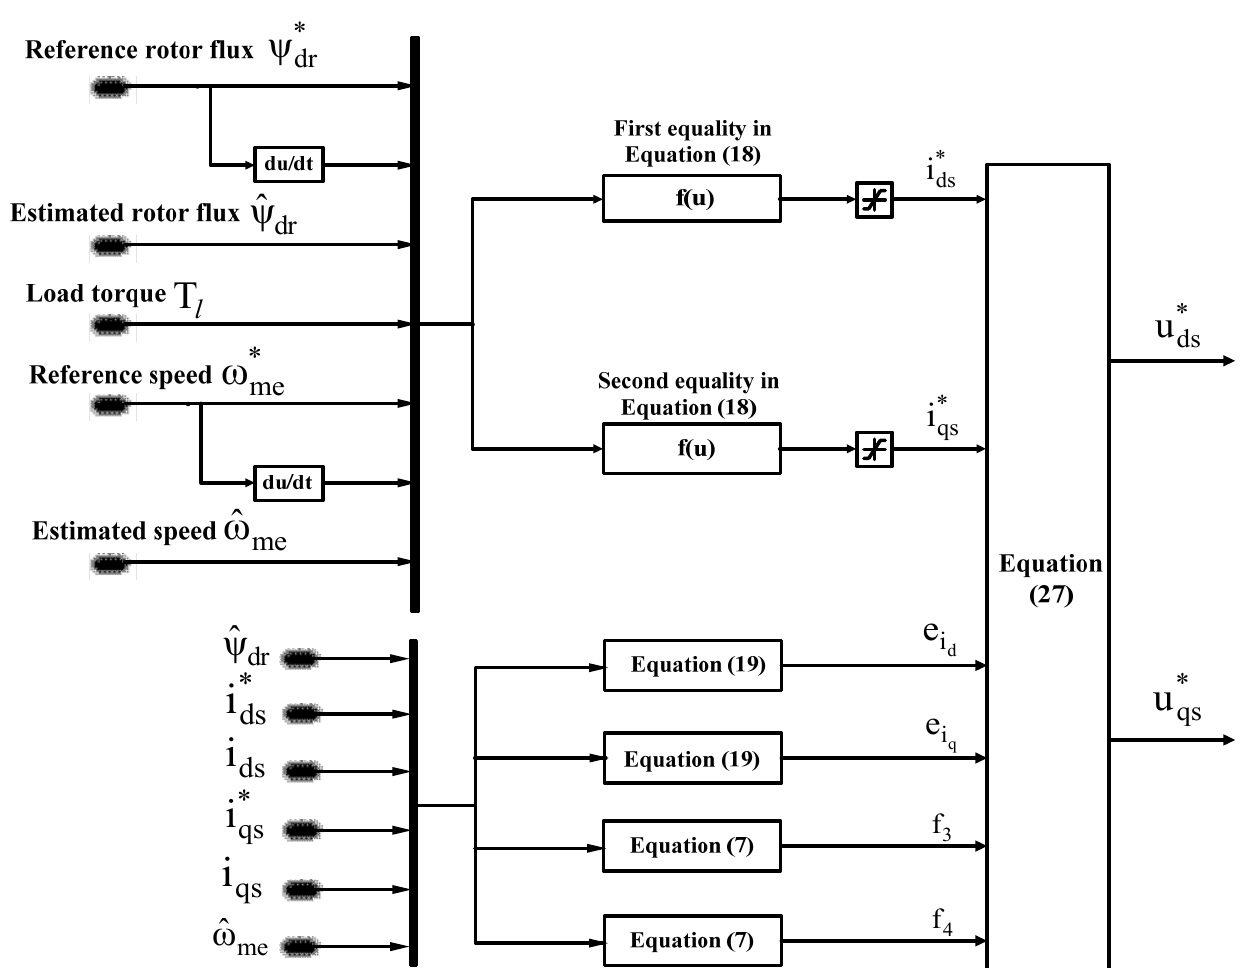
Figure 2. Layout of internal structure of backstepping